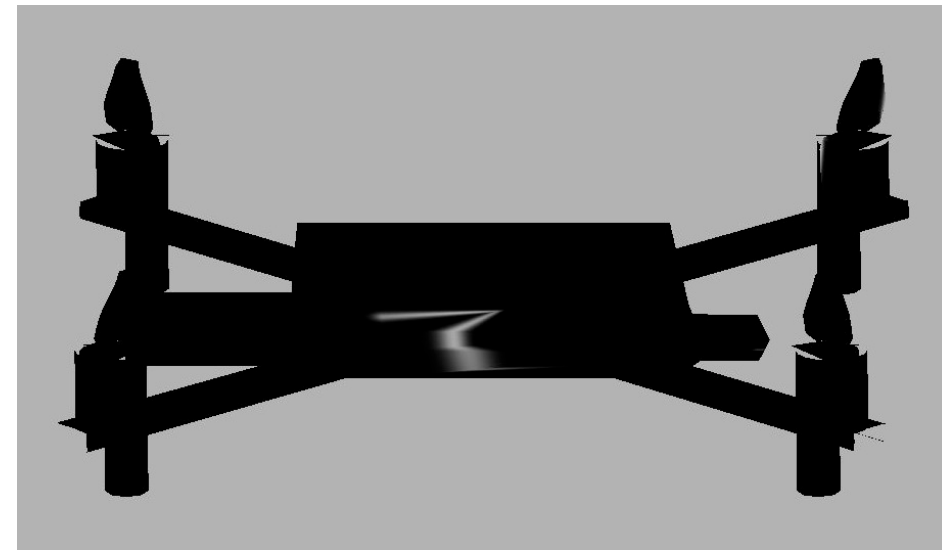
Figure 3. Fully designed virtual quadcopter.